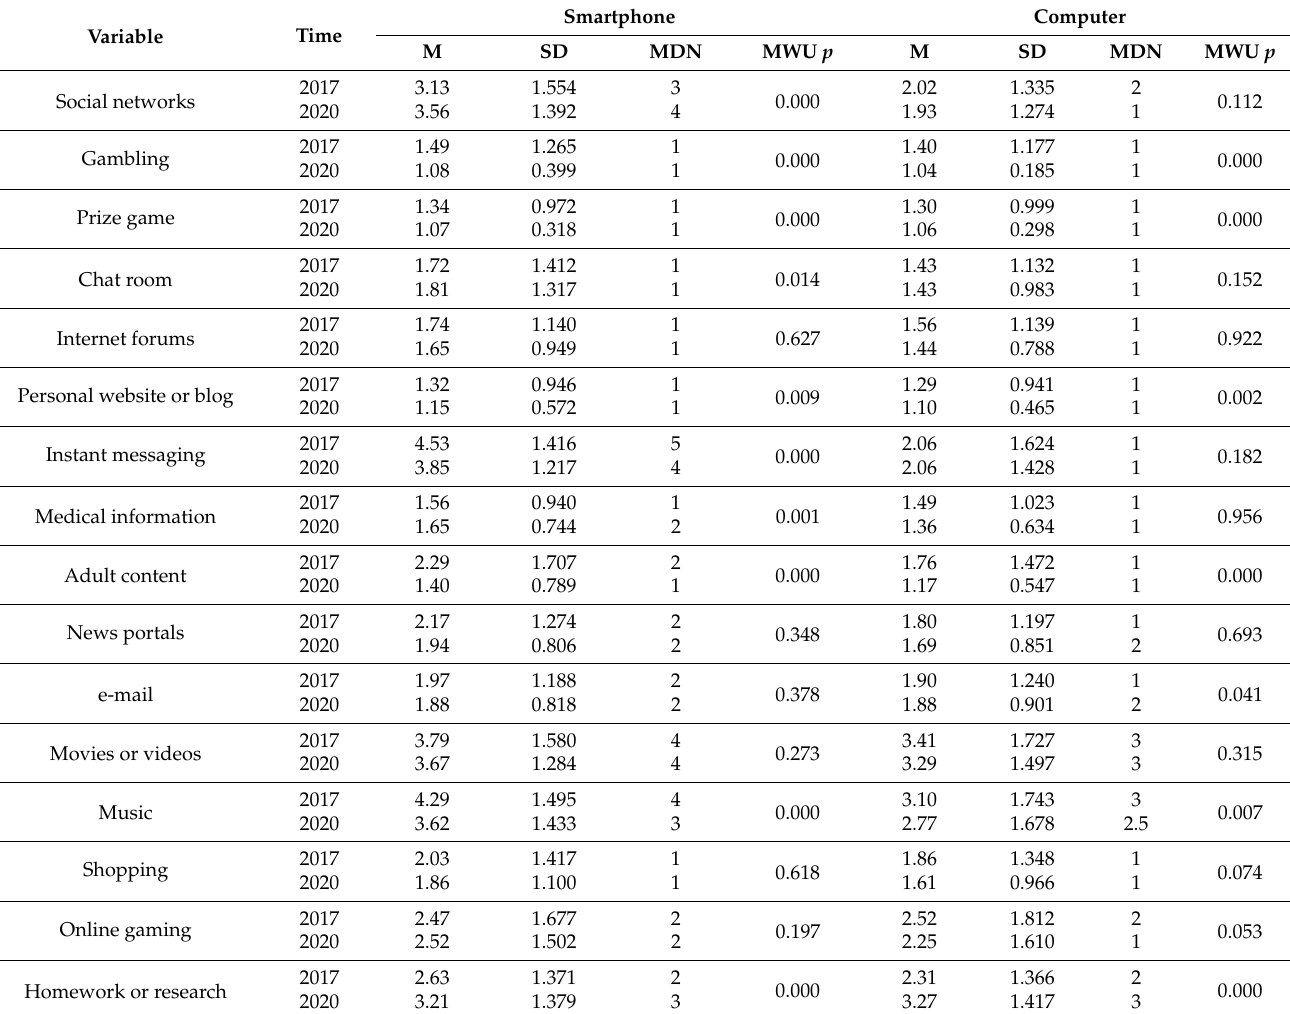
Table 2. Online activity: The comparison of the frequency of content use by smartphone and